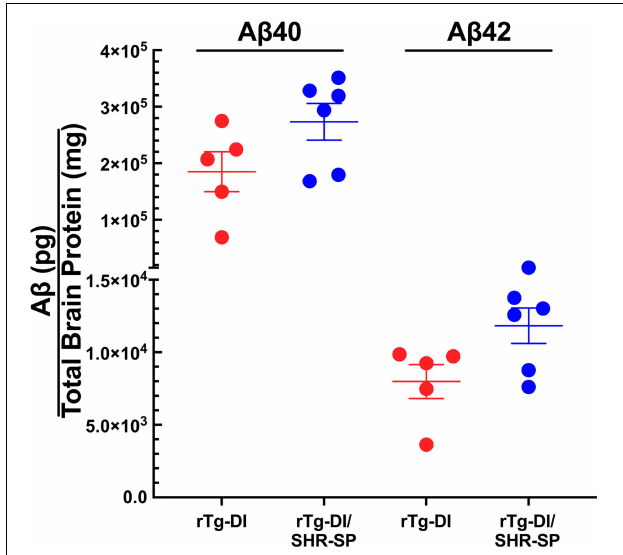
FIGURE 6 | Similar A β levels in 10 M rTg-DI and bigenic rTg-DI/SHR-SP rats. The levels of total A β 40 and A β 42 peptides in the forebrains of rTg-DI rats (red circles) and bigenic rTg-DI/SHR-SP rats (blue circles) were measured by ELISA as described under section “Materials and Methods.” The data presented are the means ± S.D. of n = 5 for rTg-DI rats and n = 6 for bigenic rTg-DI/SHR-SP rats. Unpaired t -test showed that there are no significant differences between A β 40 and A β 42 levels in rTg-DI and rTg-DI/SHR-SP